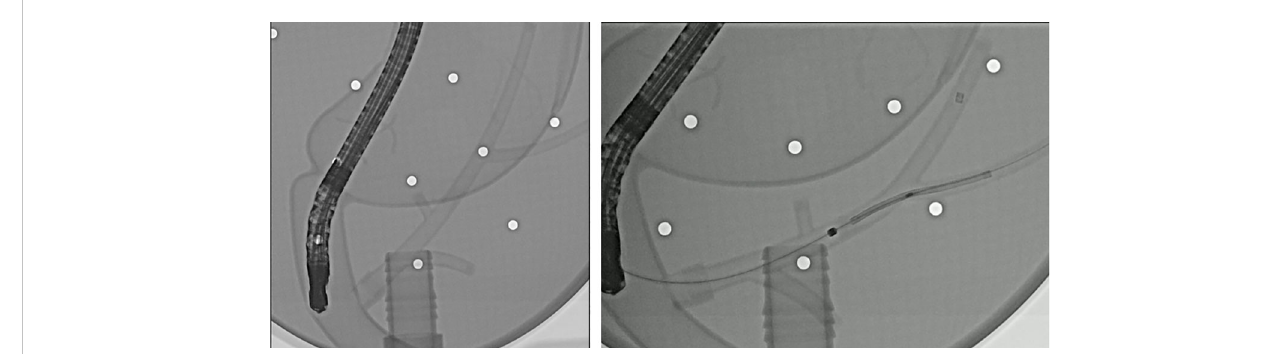
FIGURE 2 Fluoroscopic images of the endoscopic deployment of a novel biliary metal stent in a phantom